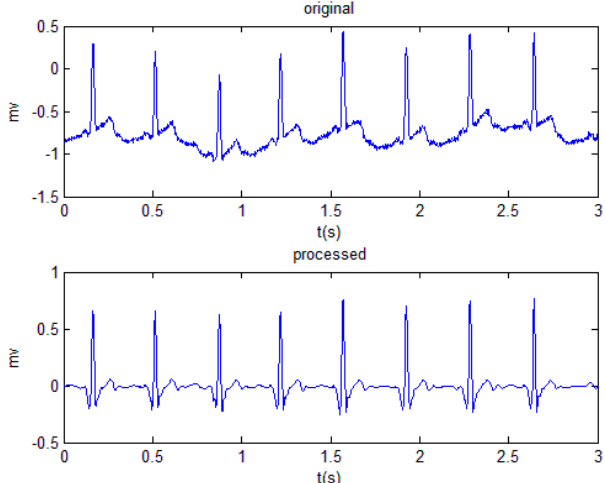
Figure 4. Comparison of the original signal and the processed signal.